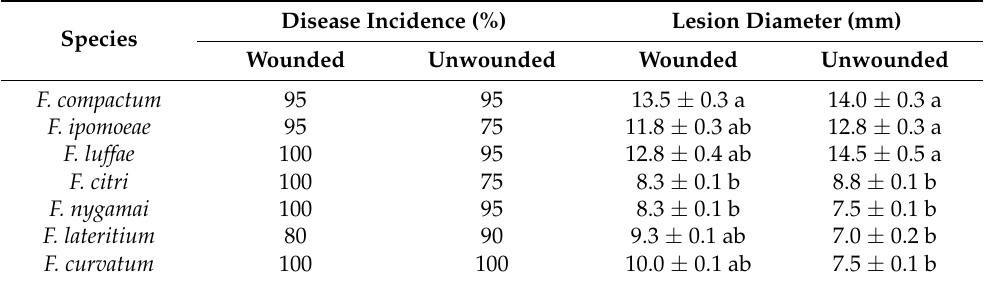
Table 4. Features of colonies and macroconidia for Fusarium species isolated in this study. (lowercase letters indicate the significant differences for lesion diameters ( p <